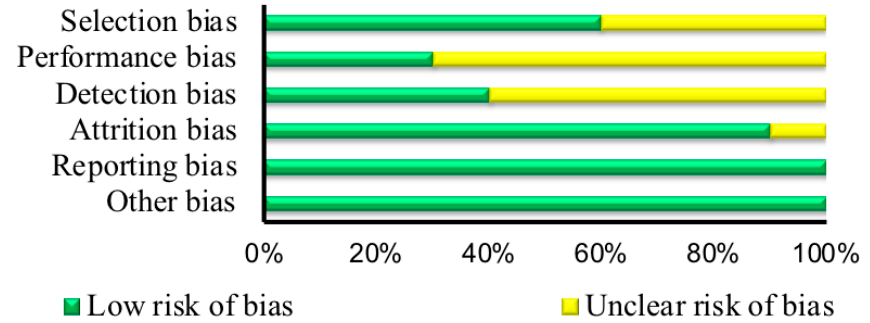
Figure 1. Summary of risk of bias assessment for randomized controlled trials ( n = 10). Selection bias (random sequence generation, low risk ( n = 2), unclear risk ( n = 8) + allocation concealment, low risk ( n = 4), unclear risk ( n = 6)); Performance bias (blinding of participants and researchers, low risk ( n = 3), unclear risk ( n = 7)); Detection bias (blinding of outcome assessment, low risk ( n = 4), unclear risk ( n = 6)); Attrition bias (incomplete outcome data, low risk ( n = 9), unclear risk ( n = 1)); Reporting bias (selective reporting, low risk ( n = 10)); Other bias, low risk ( n = 10).